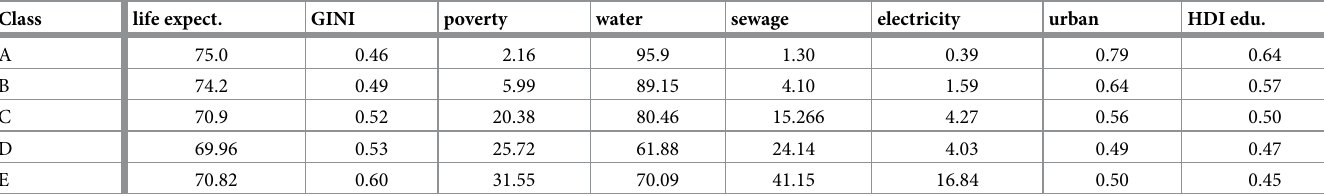
Table 1. Mean value of the descriptors in the five classes of social vulnerability in Brazil. Class life